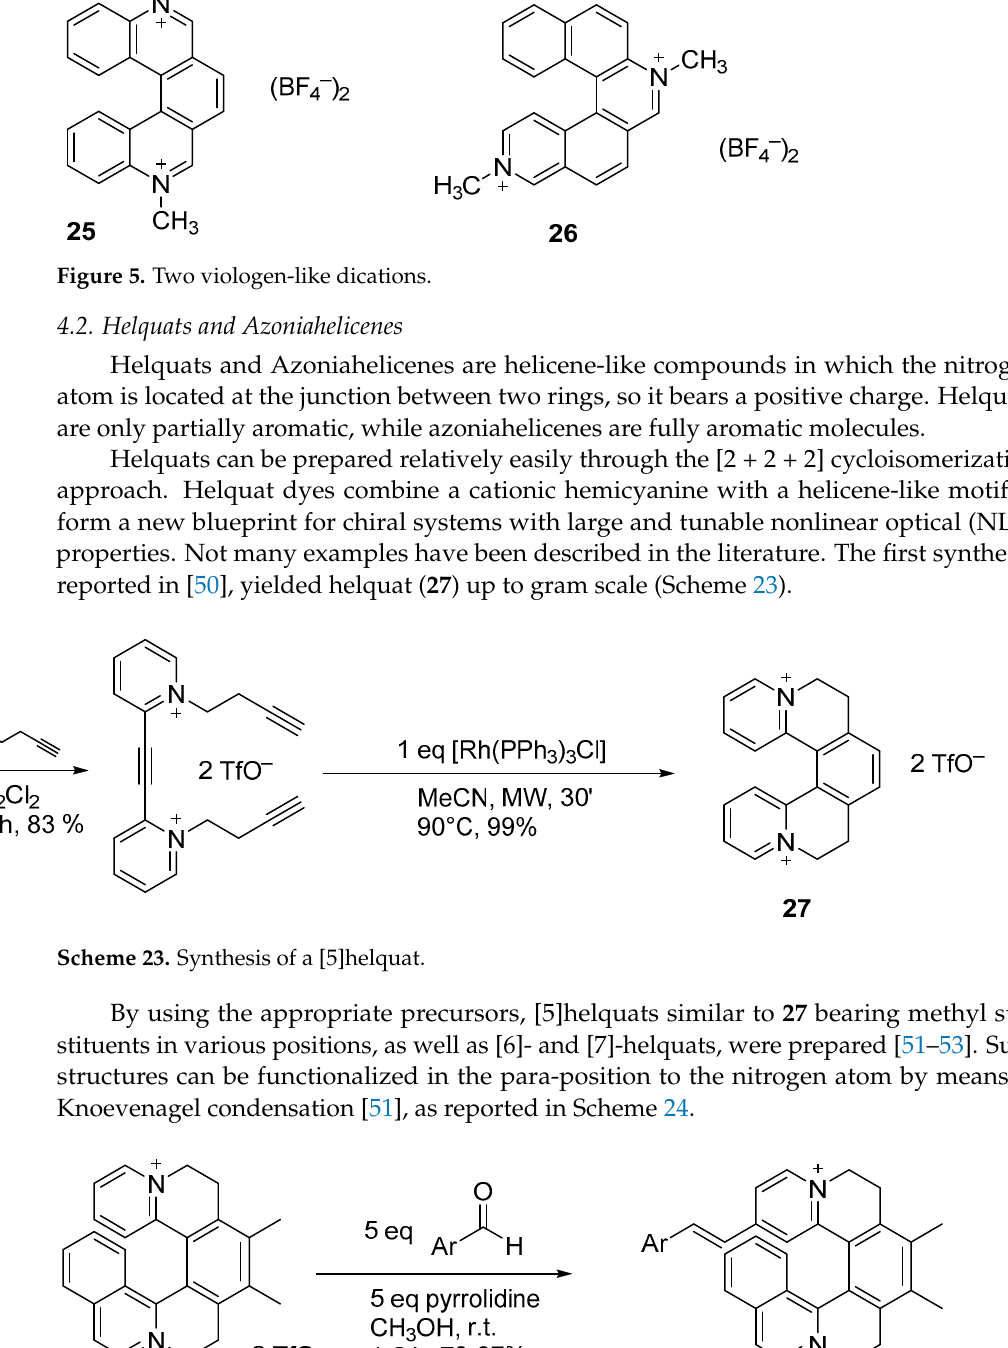
Figure 5. Two viologen-like dications.